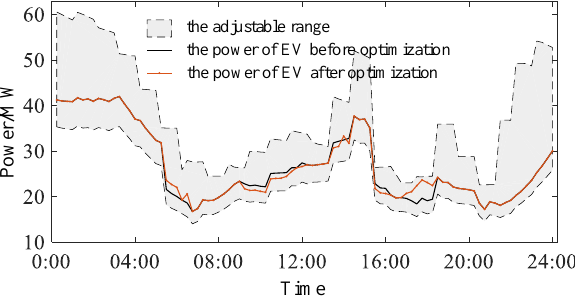
Figure 4. EV power and adjustable range under flexibility constraints.